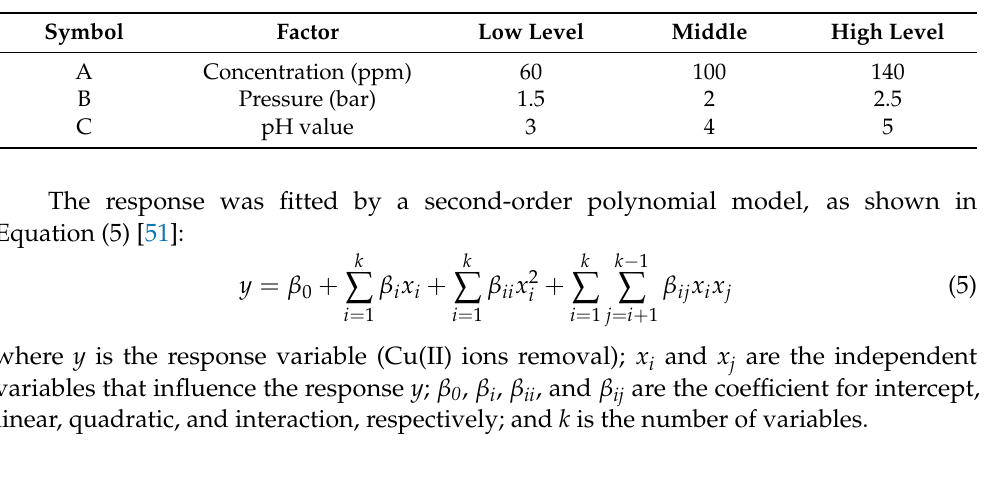
Table 1. Experimental design summary in RSM for Cu(II) ions removal by using 0.50 wt% JPU/GO